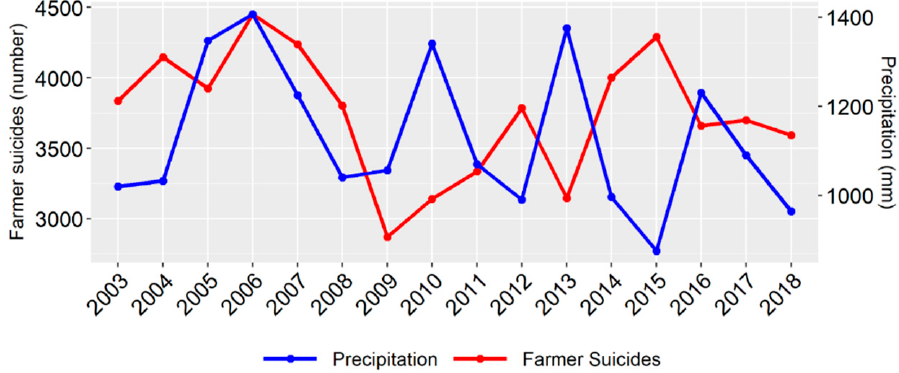
Figure 8. Number of farmer suicides and precipitation each year from 2003 to 2018. Crop failures leading to indebtedness are considered one of the primary causes of farmer suicides in Maharashtra [26], where irrigation provision is crucial, considering the drought proneness of the region [59,63]. Farmer suicides in non-irrigated areas of Maharashtra are far higher than in areas with access to irrigation (80% of farmer suicides are from non-irrigated landholdings [26,68,69]). Pande and Savenije [73] reported the acute distress of smallholder farmers (holding less than 2 to 5 ha of farmland) as a result of poor irrigation facilities and low water storage capacity. Similar observations have also been made by other researchers [28,59,63,70]. Fluctuating commodity prices, climate variability, and lack of assured water availability are some of the major concerns of farmers, along with increasing fertilizer prices, a decline in profit per hectare, and increased cost of cultivation [63,72]. Despite multiple efforts undertaken by the government [74], they have not resulted in increased irrigation efficiency in the region or stabilization of the water availability. Schemes such as debt/loan waivers provide merely temporary relief to farmers and are not a sustainable solution to the root cause of the